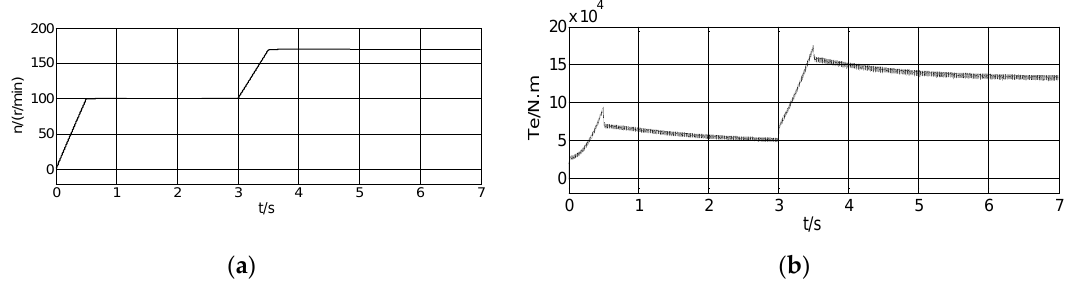
Figure 10. Waveforms of propulsion motor speed and torque: ( a ) propulsion motor speed; ( b ) propulsion motor torque.